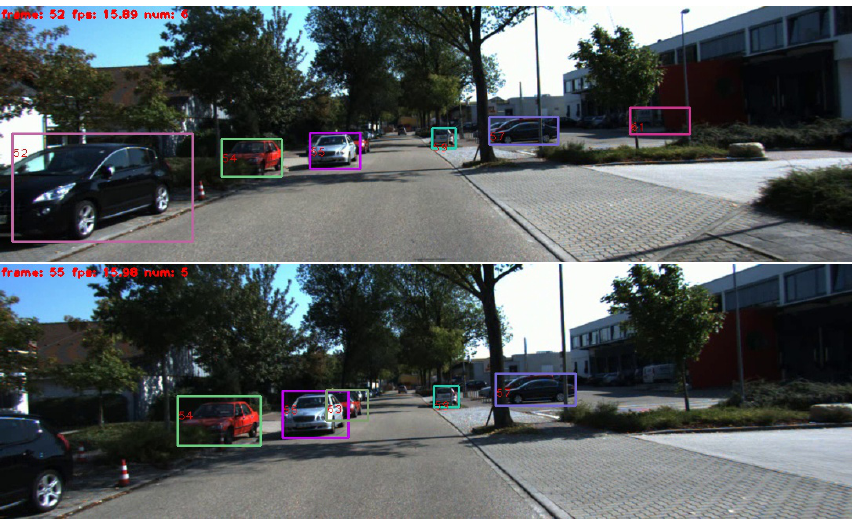
Figure 4. Qualitative results of our visual-based tracker on KITTI. The color of each bounding box indicates the target identity. The number of frames, fps and tracked objects is shown in the upper left corner of each image.